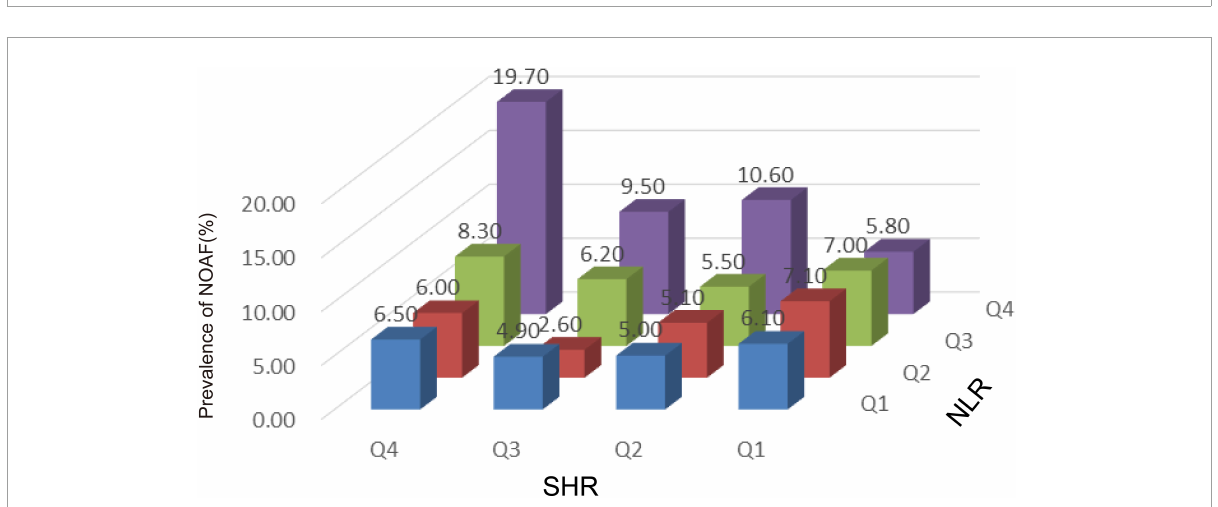
FIGURE3 The incidence of new-onset atrial fibrillation (NOAF) in patients with acute myocardial infarction (AMI) based on stress hyperglycemia ratio (SHR) tertiles in patients grouped by neutrophil to lymphocyte ratio (NLR) tertiles. NLR, neutrophil to lymphocyte ratio; SHR, stress hyperglycemia ratio; NOAF, new-onset atrial fibrillation.